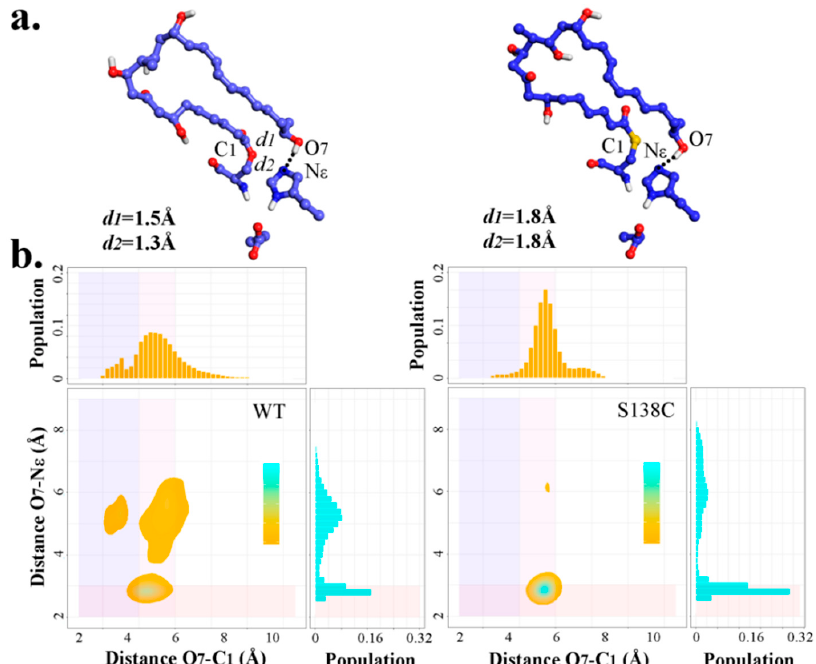
Figure 9. ( a ) Diagram of representative PRS conformations in wild type ( left ) and S138C ( right ) trajectories. ( b ) Density map and marginal histogram indicating the distribution of all frames on the basis of distances O 7 -N ε H261 and O 7 -C 1 in wild type and S138C trajectories. The rectangles in light-coral, slate-blue, and thistle highlight points with distance (O 7 -N ε H261 ) ≤ 3.0 Å, distance (O 7 -C 1 ) ≤ 4.5Å and 4.5Å ≤ distance (O 7 -C 1 ) ≤ 6.0Å, respectively.